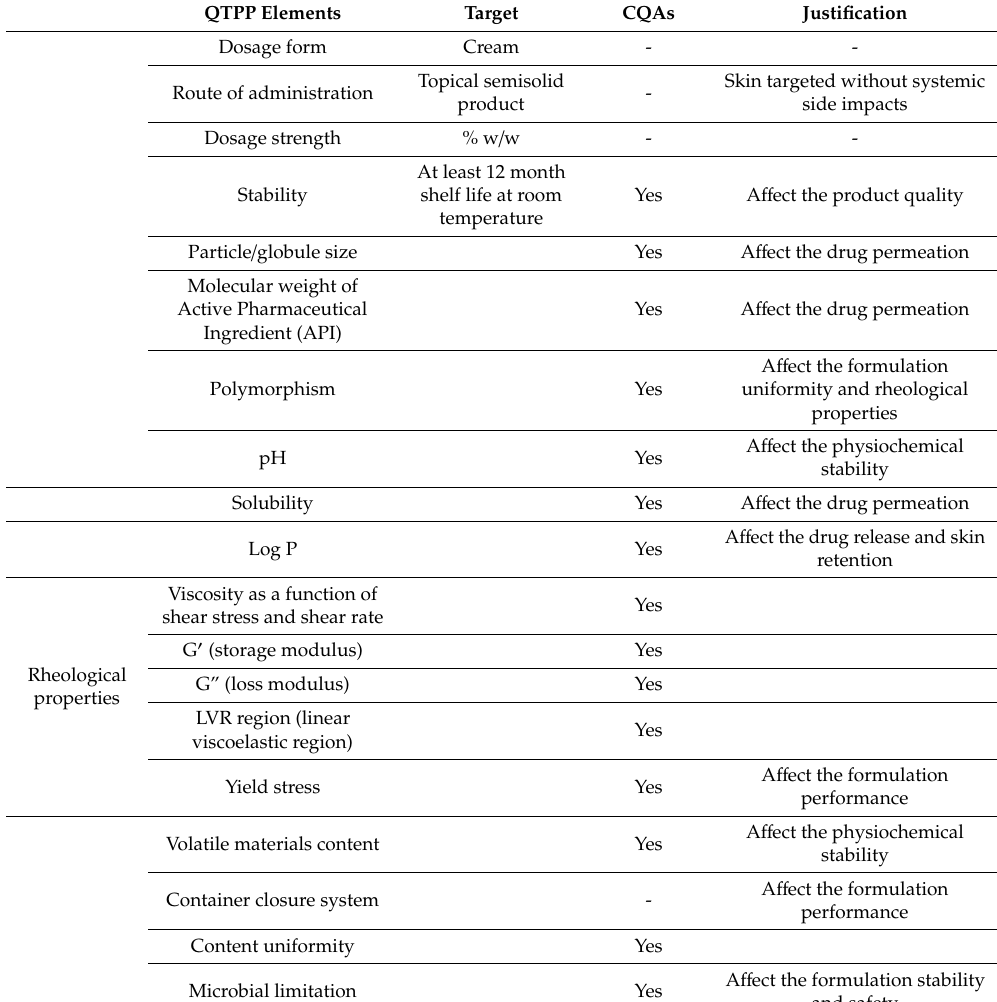
Table 1. Quality target product profile (QTPP) example for a topical